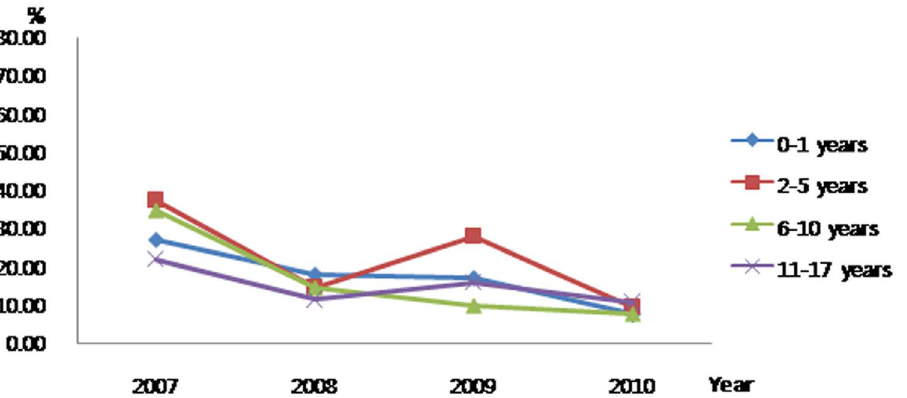
Figure 3. Trends for the administering CPR as aggressive end-of-life care to Korean pediatric cancer patients who died 2007–2010.